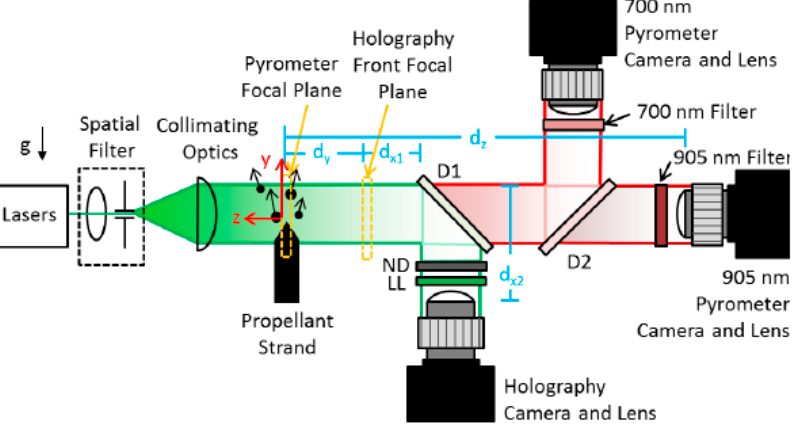
Figure 39. Setup for combined DIH and pyrography. Reprinted with permission from Ref. [48] (2017).